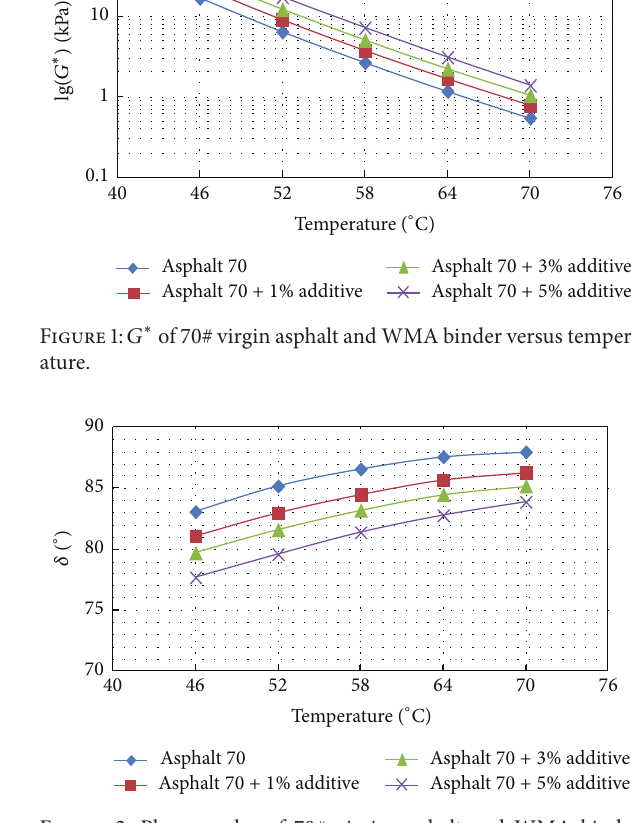
Figure 2: Phase angles of 70# virgin asphalt and WMA binder versus